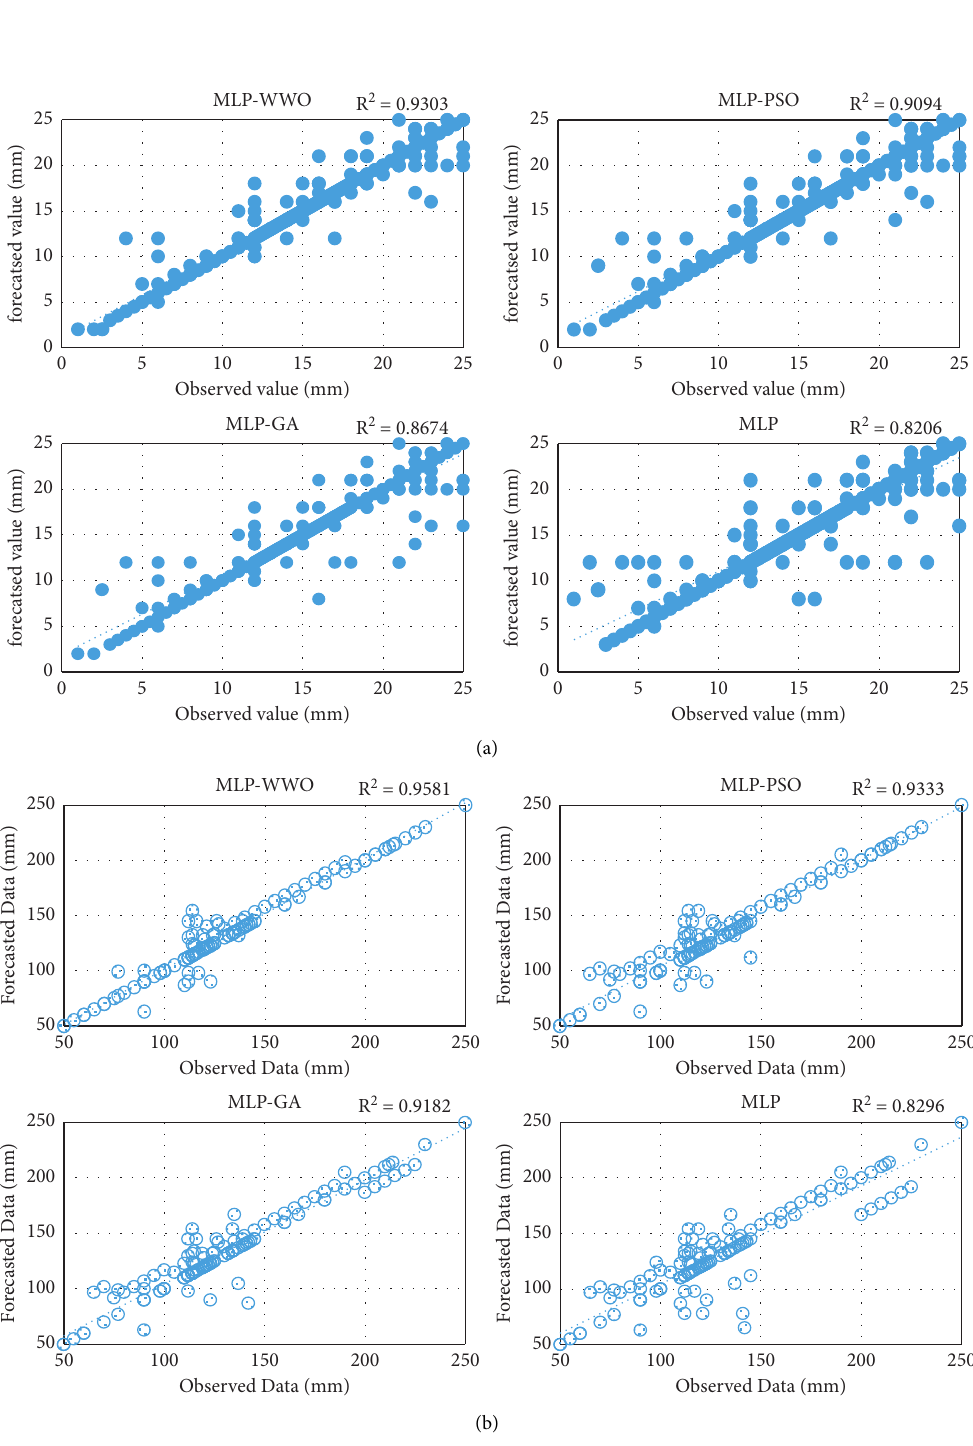
Figure 9: Scatter plots for (a) daily values and (b) monthly values. Table 6: Classification of hydrological model [40]. Goodness of fit The accuracy of